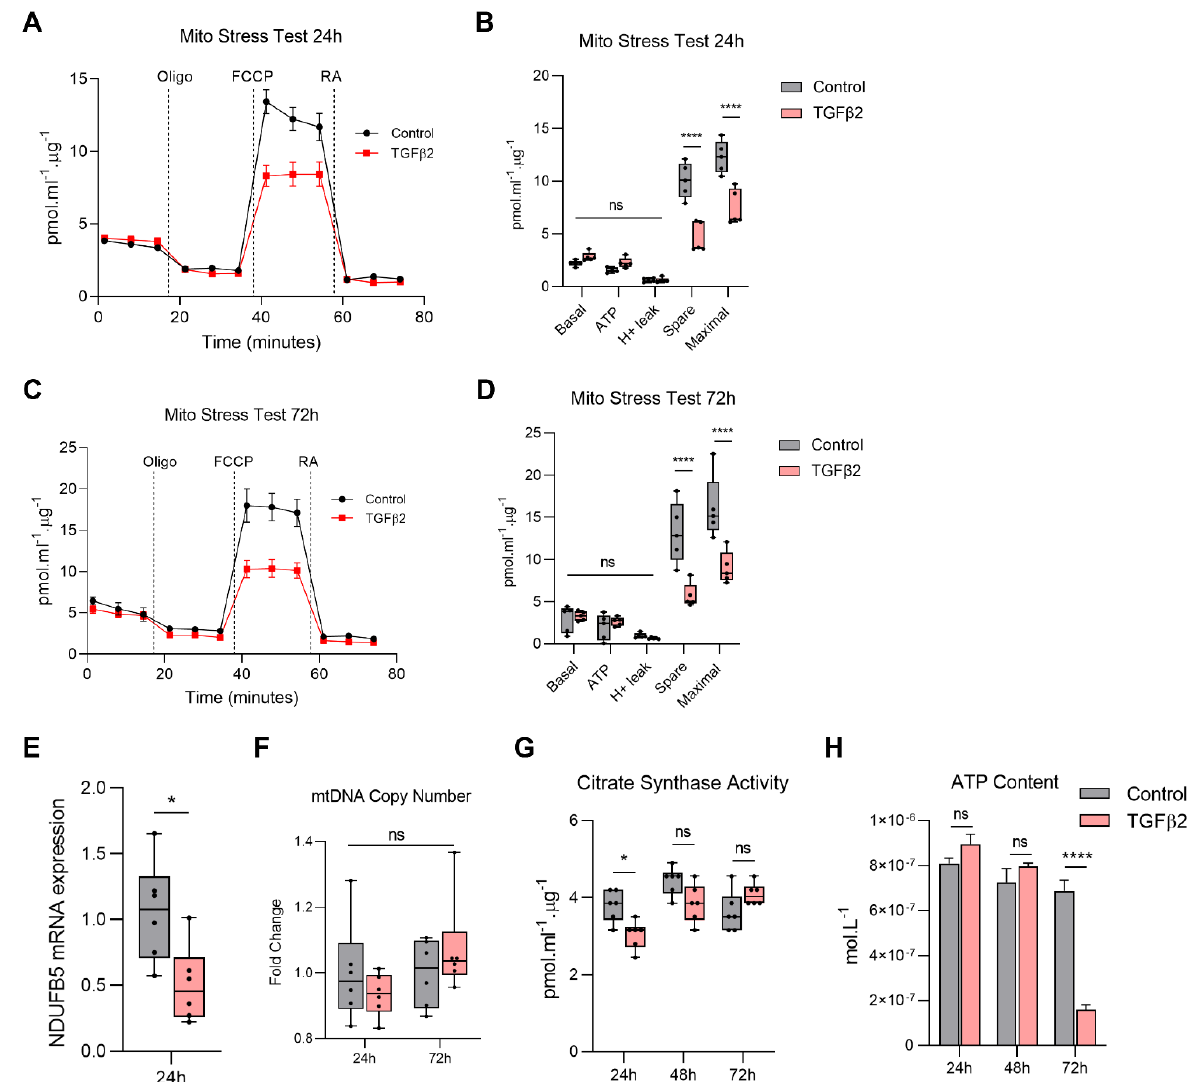
Figure 2. TGFβ2 reduces mitochondrial respiration in RPE. Real-time measurement of oxygen consumption rate (OCR) using the Seahorse XF24 BioAnalyzer to assess OXPHOS parameters: basal respiration, ATP-linked respiration, proton leak, spare respiratory capacity and maximal respiration based on responses to drug injections of oligomycin (Oligo), FCCP and rotenone and antimycin A (RA) at ( A , B ) 24 h and ( C , D ) 72 h in ARPE-19 treated with and without TGFβ2 ( n = 5, one-way ANOVA with Tukey’s post-hoc analysis). ( E ) Quantification of NDUFB5 gene expression following treatment with or without TGFβ2 at 24 h ( n = 6, unpaired t -test). ( F ) Quantification of mitochondrial DNA (mtDNA) copy number using qPCR with and without TGFβ2 for 24 and 72 h ( n = 6, one-way ANOVA with Tukey’s post-hoc analysis). Error bars are means ± SEM. * p ≤ 0.05; ** p ≤ 0.01; ns, not significant. ( G ) Quantitation of citrate synthase activity ( n = 6) and ( H ) Intracellular ATP content at 24, 48 and 72 h with or without TGFβ2 ( n = 3, one-way ANOVA with Tukey’s post-hoc analysis). Error bars are means ± SEM. * p ≤ 0.05; **** p ≤ 0.0001; ns, not significant.